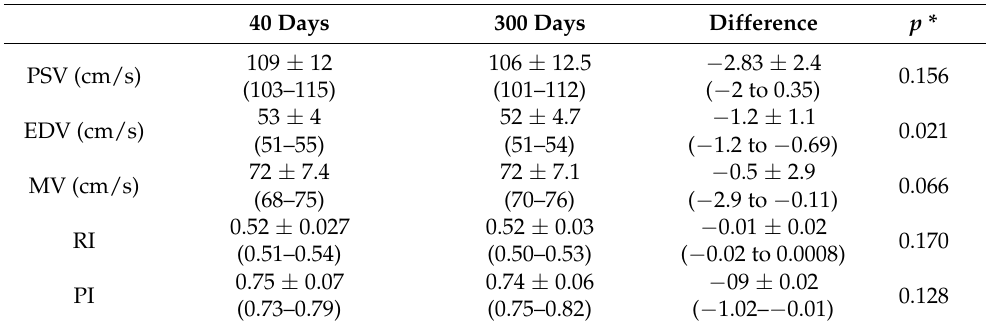
Table 8. Arithmetic means of MCA flow rates ± SD (95% CI) at rest period 40 days and 300 days from the onset of COVID-19.